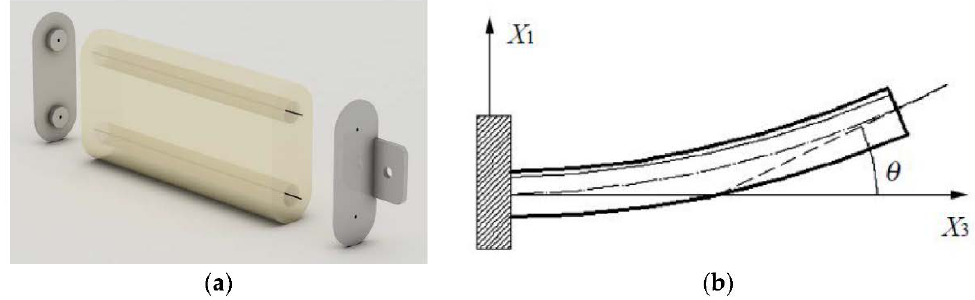
Figure 2. ( a ) is an example of the sensor placement along the soft cylindrical body, these sensors are placed at even intervals to align with the x and y axes. The locations of the sensors would be on the opposite side of other sensors in this example, which would have them all around the cylinder. ( b ) is a schematic of a constant curvature beam on the cylindrical body itself (Reprinted with permission from Liu, M. et al. [25]. Copyright 2021, CC BY 4.0